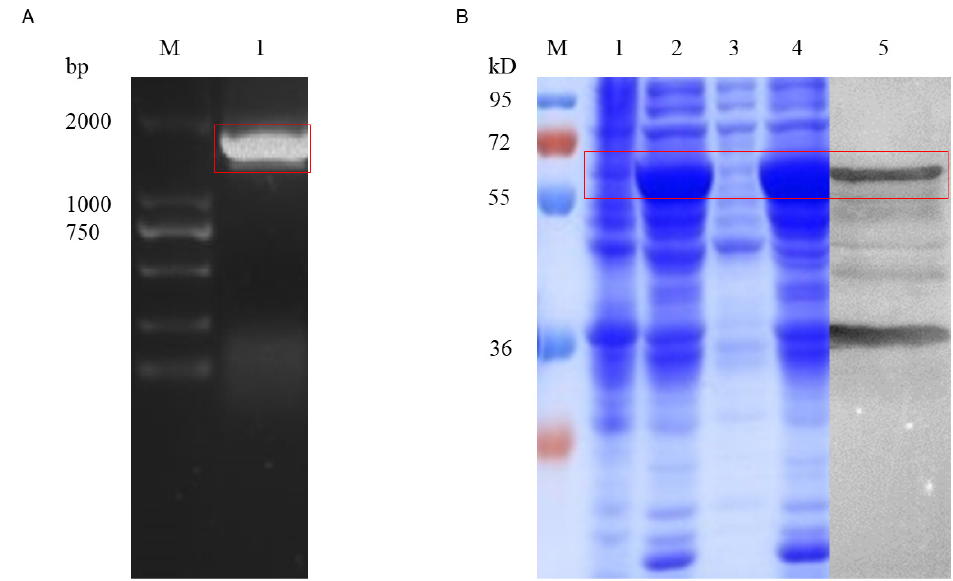
Figure 1. Cloning and expression of the UGT46A1 gene. ( A ) Electrophoretogram of the UGT46A1 gene by PCR amplification. M: DNA marker; 1: PCR product of UGT46A1 gene; the strip in the red box is UGT46A1 . ( B ) The prokaryotic expression of the UGT46A1 protein was detected by SDS-PAGE and Western blot with His tag. M: Protein marker; 1: Empty vector; 2: Total bacterial lysate induced by IPTG (4 h after induction with 0.5 mM IPTG, 37 °C); 3: supernatant after the ultrasonic breakdown of total lysate; 4: precipitate after ultrasonic breakdown; 5: Western blot exposure image of the UGT46A1 protein. The strip in the red box is the UGT46A1 protein.